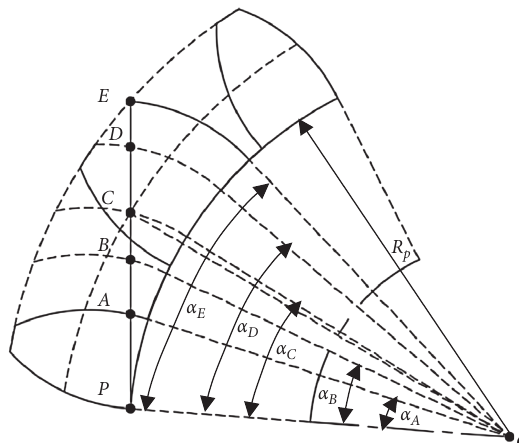
Figure 5: Schematic diagram of spread angle of initiative